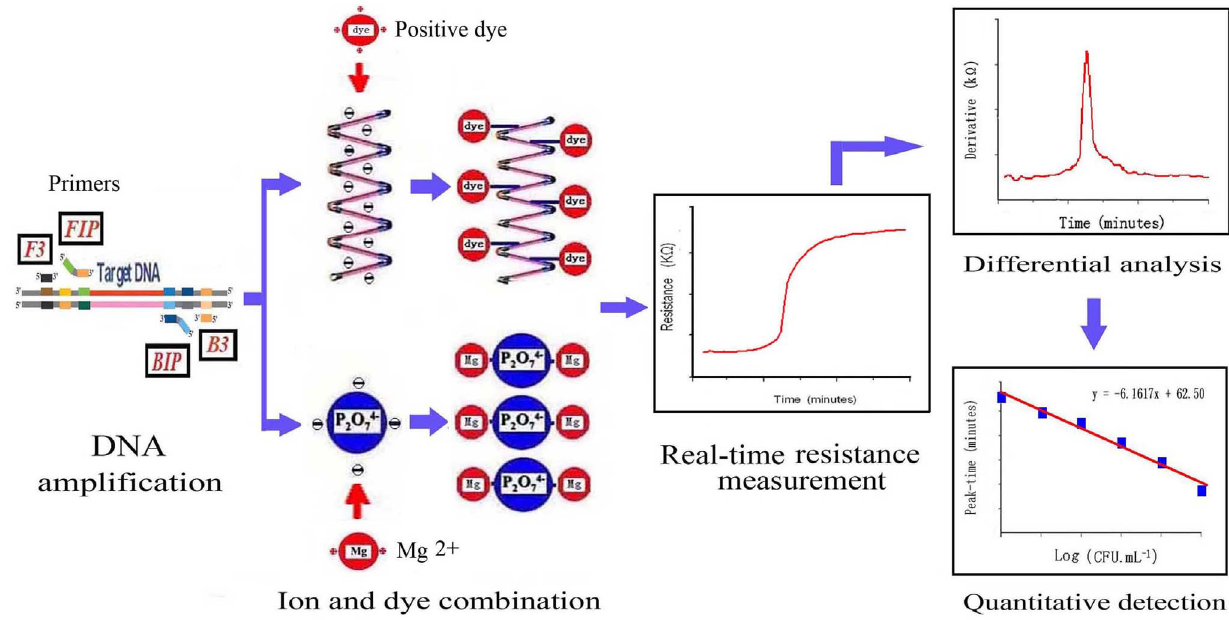
Figure 1. Schem e of the real-time resistance measurement for V.parahaemolyticus . Briefly, the lecithin-dependent hemolysin (LDH) gene of V. parahaemolyticus was amplified by LAMP at first. The subsequent two products, DNA and pyrophosphate, both negative ions, were combined with a positive dye (Crystal violet) and positive ions (Mg2 + ), leading to an increase in the reaction liquid resistance. This resistance was measured in real- time using a electrode, and V. parahaemolyticus concentration was quantitatively detected through a derivative